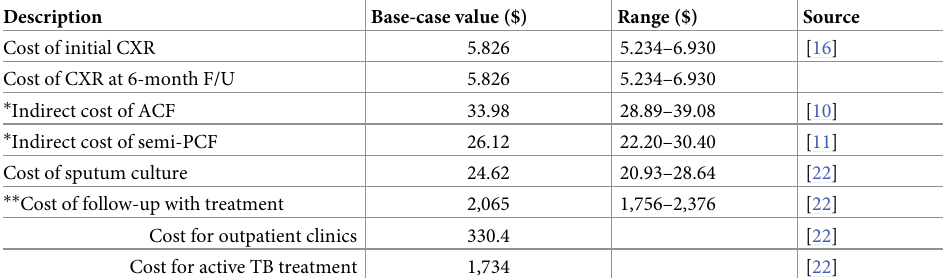
Table 4. Base-case value per patient, range, and description of costs in cost-effectiveness analyses for ACF with CXR and semi-PCF with